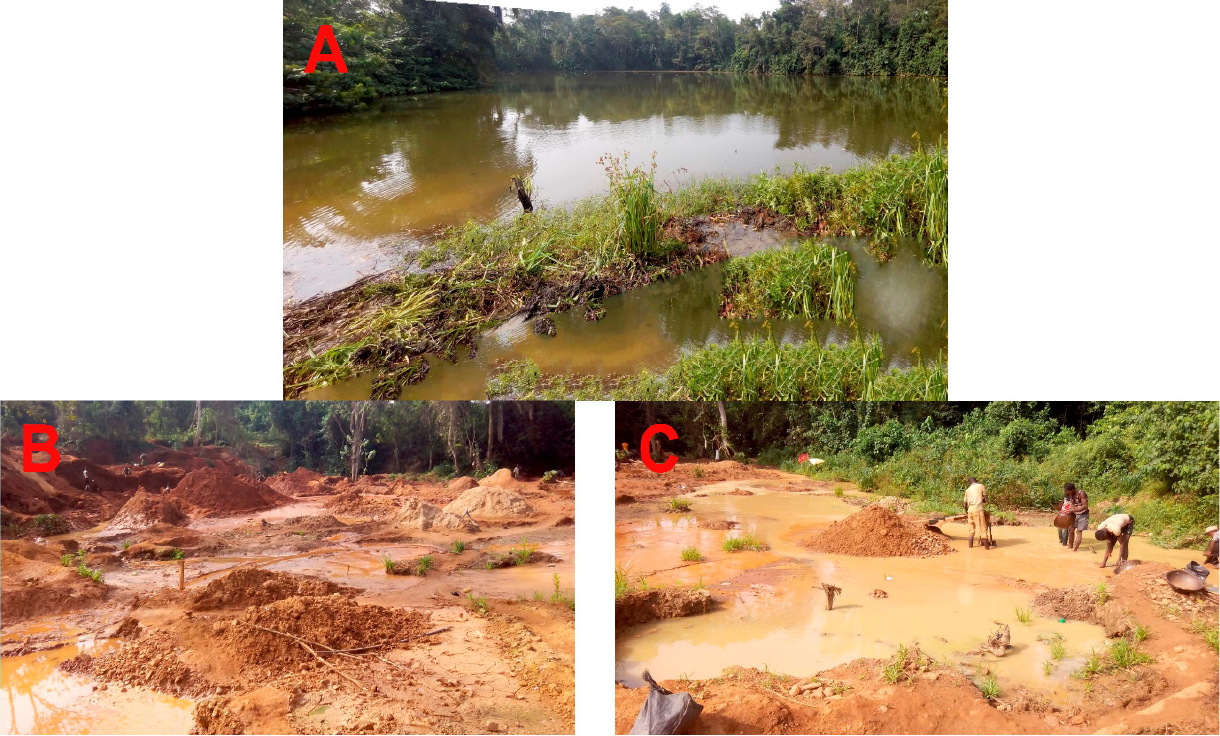
Fig. 2. Reservoir 5 at Igun showing (A) its view and the surrounding vegetation, (B) heaps of earth at the nearby mining site and, (C) miners at work processing gold with their locally made